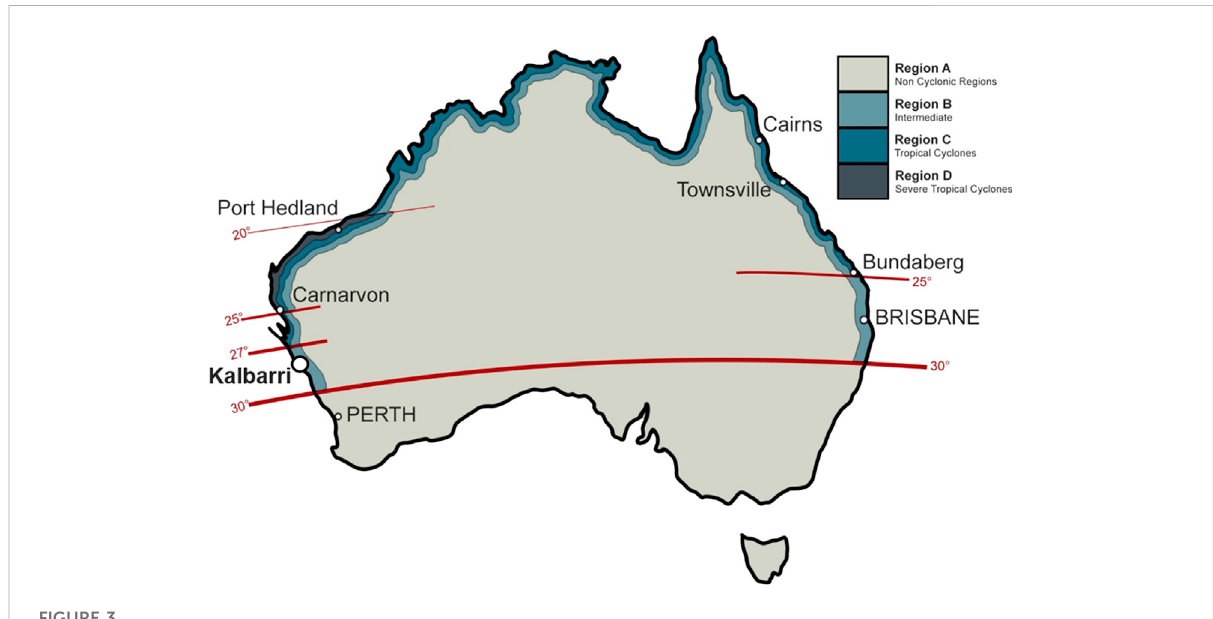
FIGURE 3 Wind regions in